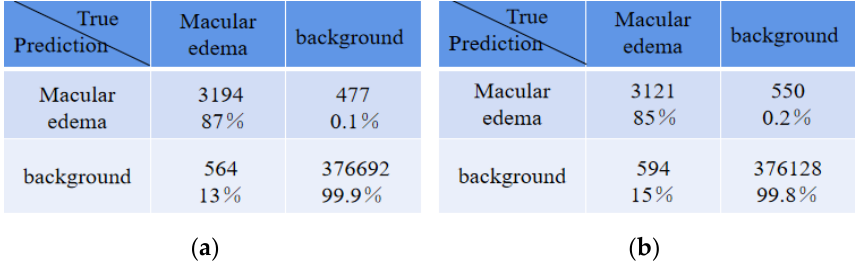
( b ) Figure 11. Quantitative comparison of confusion matrices: ( a ) the proposed method; ( b ) ReLayNet. Figure 12 shows the comparison of ROC curves. The AUC value of 0.997 of the proposed method was 0.011 values higher than ReLayNet at 0.986. Figure 12. Comparison of ROC curves.